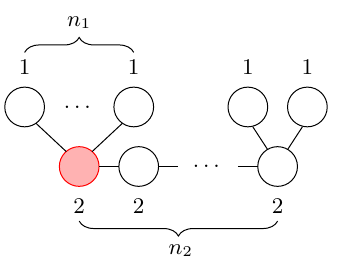
Figure 25 . fP ( n 1 ), P (2) g quiver with SU(2) n 1 (cid:2) D n [1 n 1 ] [1 2 ] dim M H = n 1 + 2 n 2 + 1. C